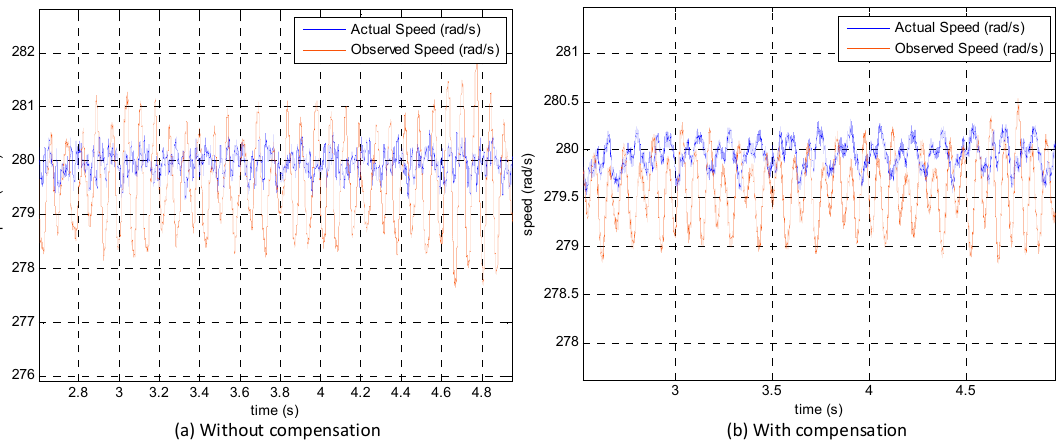
Figure 16. The experimental results of actual speed and observer speed at 280 rad/s.